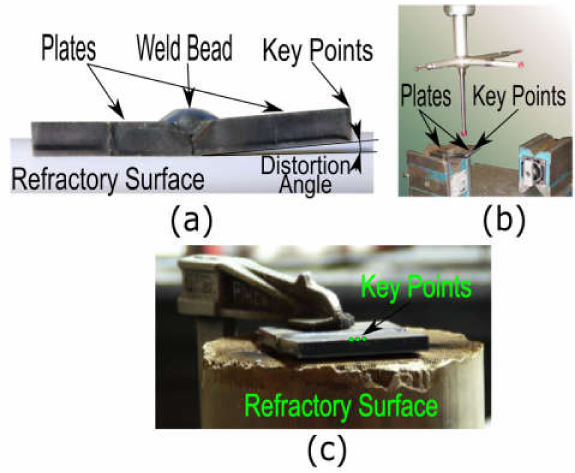
Figure 3. ( a ) The distortion angle measured in the butt joint single V-groove; ( b ) Coordinate-measuring machine used to determine the angular distortion; and, ( c ) Detail of the Key points